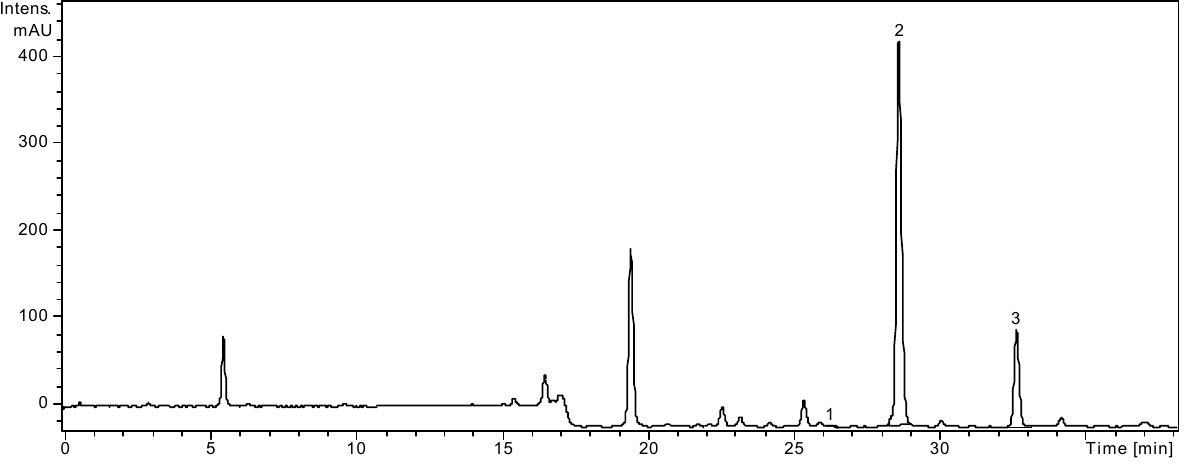
Figure 1. HPLC chromatogram of A. distans subsp . distans.